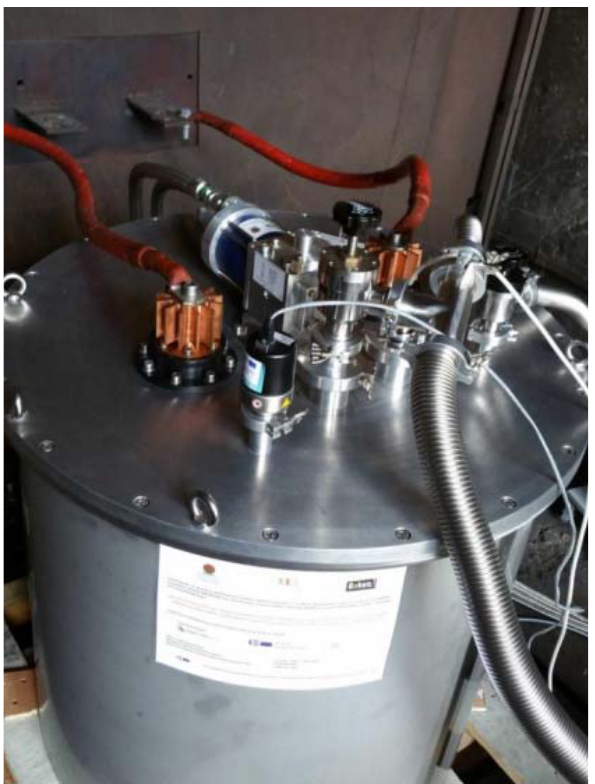
Figure 1. The third medium voltage SFCL tested in the Short-Circuit Endurance Testing Laboratory of the Institute of Electrical Engineering in Warsaw.